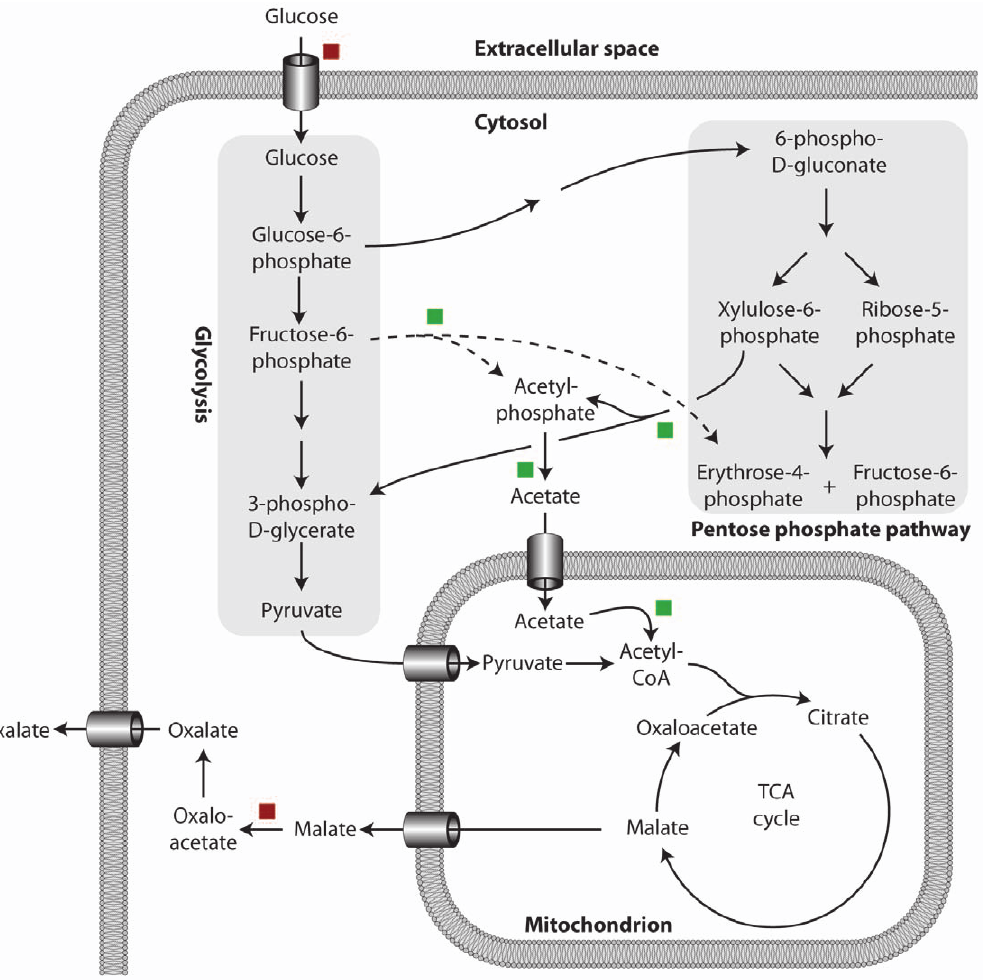
Figure 4. Metabolic map illustrating the response of central carbon metabolism caused by the oafA deletion. A red box indicates up- regulation of a gene encoding an enzyme catalyzing this reaction. Green box indicates down-regulation. The dotted line indicates fructose-6- phosphate phosphoketolase, a reaction not previously described within the fungal kingdom.